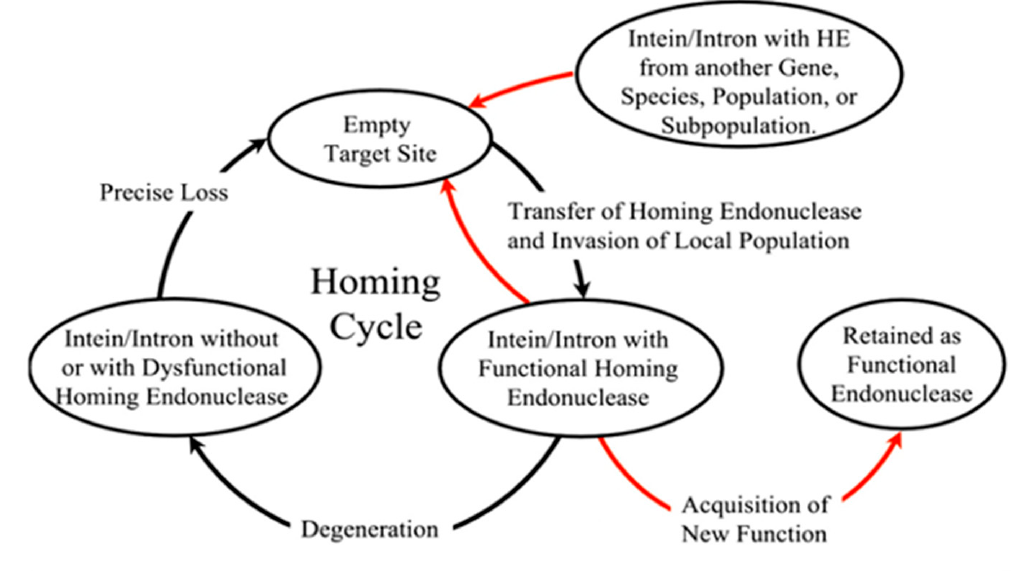
Figure 4. Homing cycle of a parasitic genetic element. Recent findings suggest that due to complex population structure the cycle might not operate in synchrony in di ff erent subpopulations. The red arrows indicate the trajectory of the functioning HE and the black arrows indicate the fate of the host gene. The precise loss can occur through recombination with an intein- or intron-free allele, or, in the case of introns, through recombination with a reverse transcript of the spliced mRNA [51]. The relative fitness of an organism directly correlates to the presence or absence of homing endonuclease and intein. Butler et al. had a suggestion that inteins may decrease the fitness of a host organism [43]. Although according to the rock–paper–scissor theory proposed by Brazel et al., while considering the fitness cost of three alleles: X with an empty target site, Y with a dysfunctional homing endonuclease and Z with a functional homing endonuclease. Carriers of X-allele will be